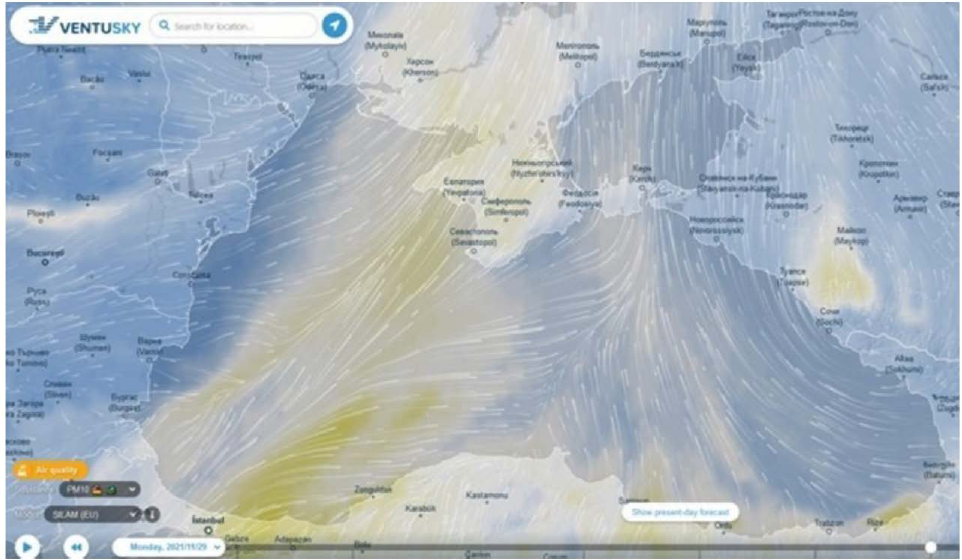
Figure 9. Aerosol transport on 29 November 2021 according to the website https://www.ventusky. com (accessed on 14 June 2022).